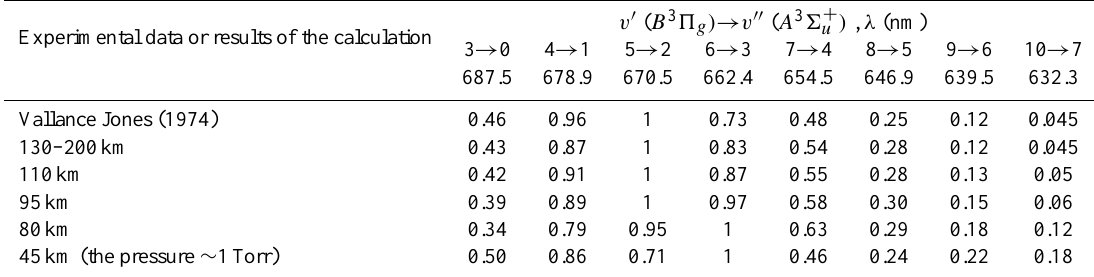
Experimental data or results of the calculation